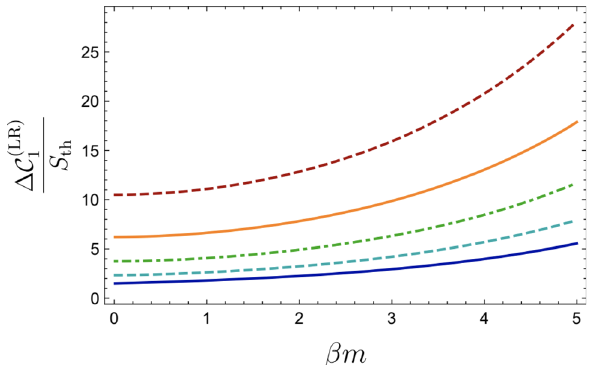
Fig. 11 Complexity of formation as a function of the mass in various dimensions from d = 2 (bottom curve) to d = 6 (top curve). Figure taken from [66]